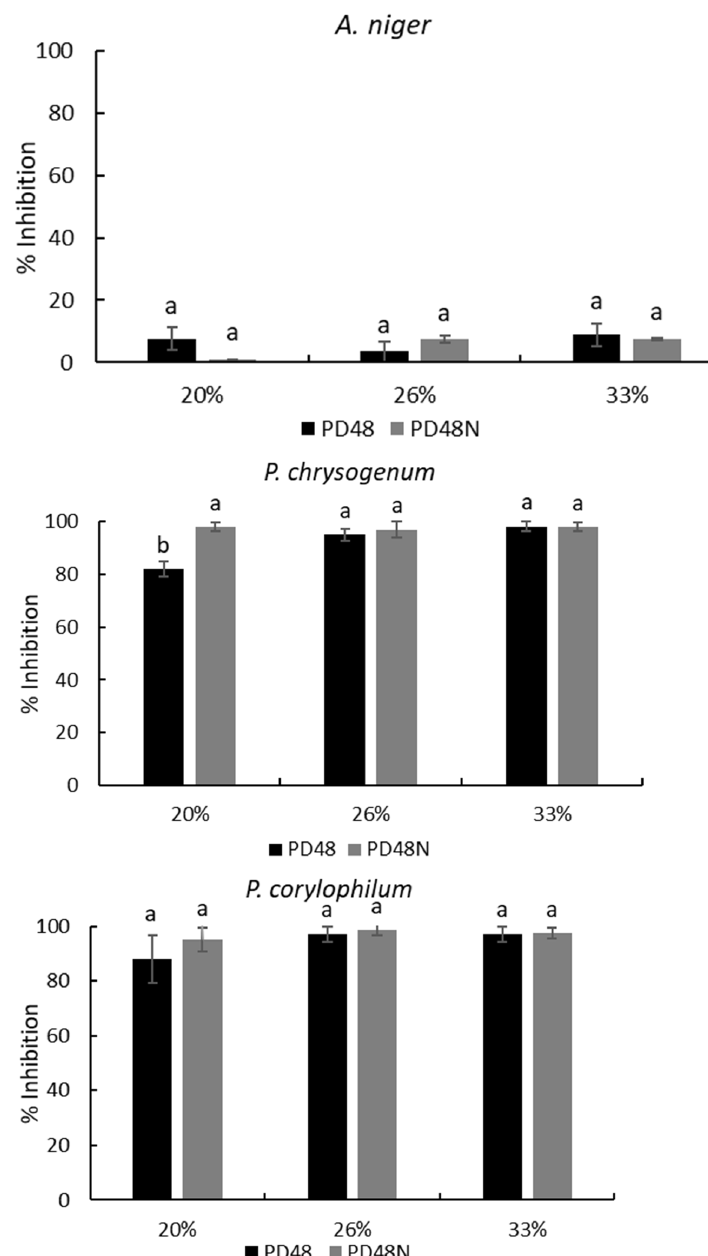
Figure 3. Percentage of inhibition (plate counts) of native (PD48) or neutralized (PD48N) aqueous extracts (AEs) obtained from the sourdough fermented with Lactiplantibacillus plantarum NRRL B-4496 after 48 h at three concentrations. Different lowercase letters indicate significant differences ( p < 0.05) with respect to native or neutralized AEs.